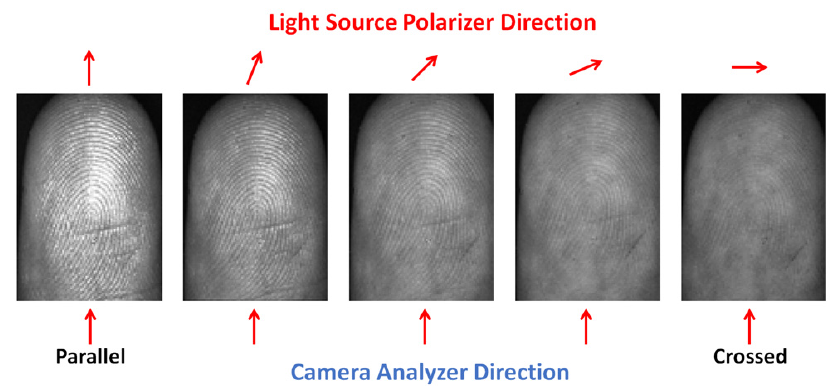
Figure 8. Effect of relative polarization angle on surface contrast.